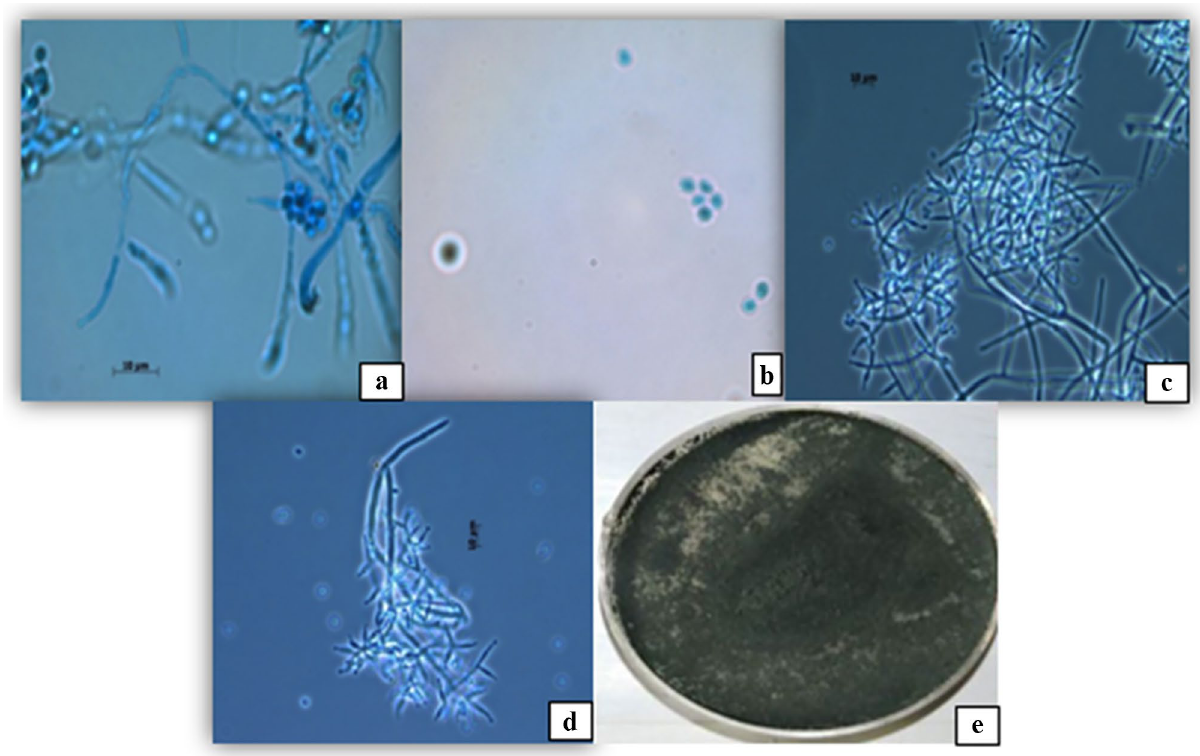
Figure 1. Microscopic characters of Trichoderma asperellum ( a ) conidiophore, ( b ) conidia ( c ), hyphae, ( d ) fialida, ( e ) colonial morphology of FbMi-6 on PDA